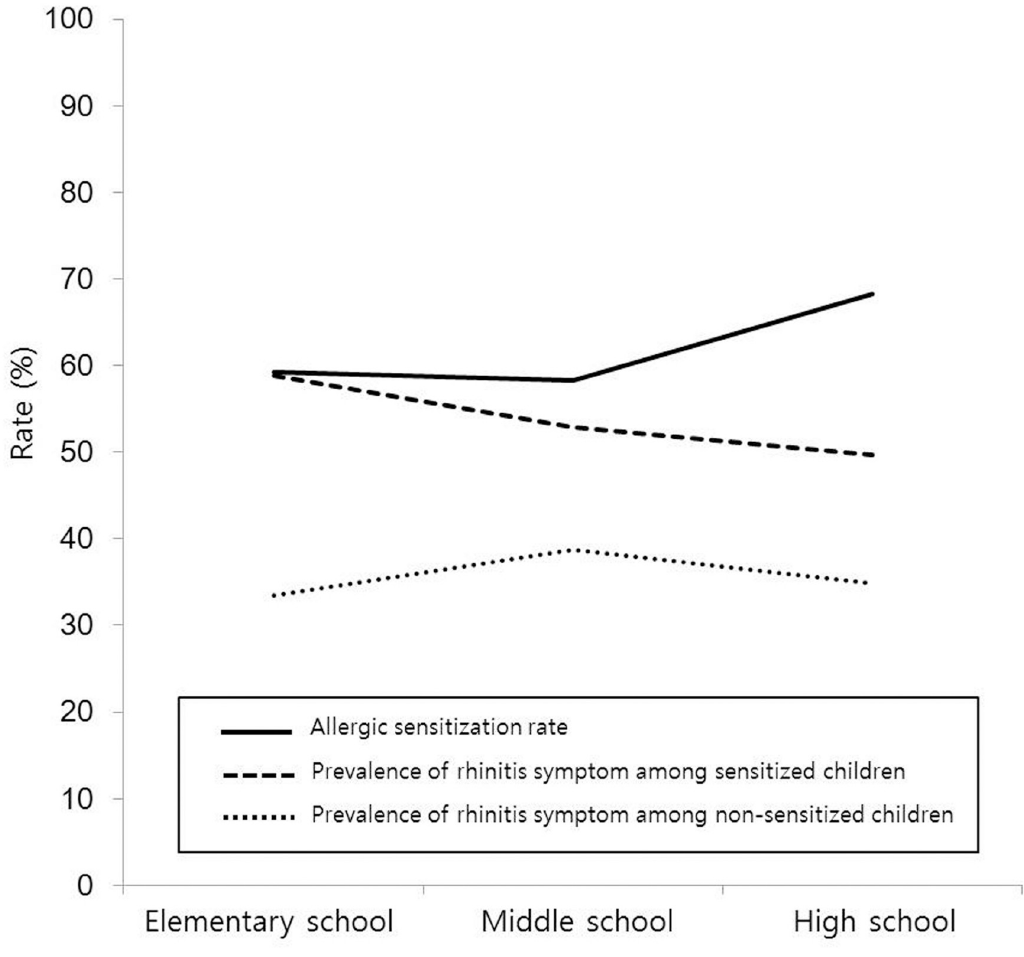
Fig 3. Prevalence of rhinitis symptom in sensitized and non-sensitized children according to age group.